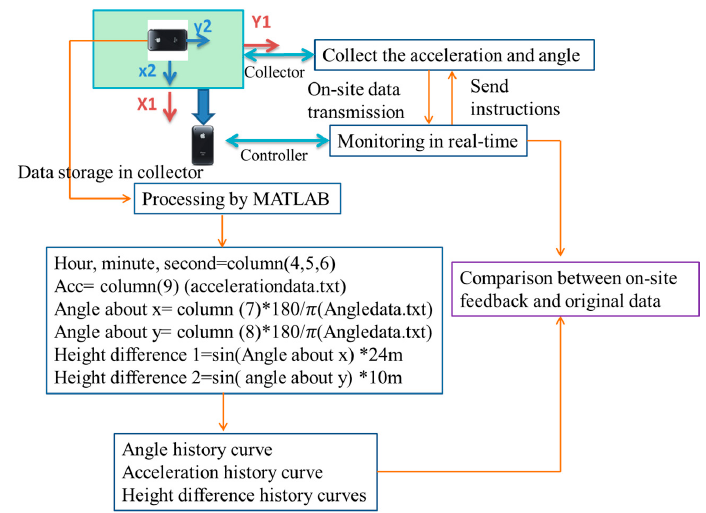
Figure 24. Algorithm of middle-span hoisting monitoring.